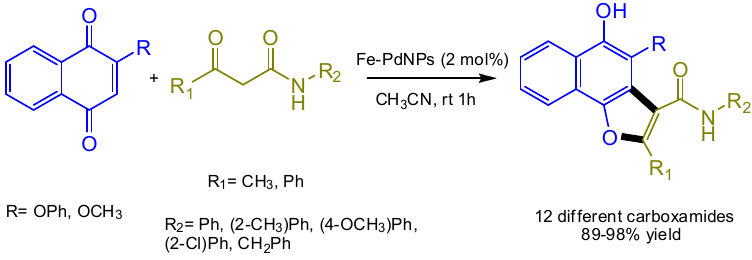
Figure 13. Synthesis of substituted carboxamides catalyzed by Fe-Pd NPs nanocatalyst.